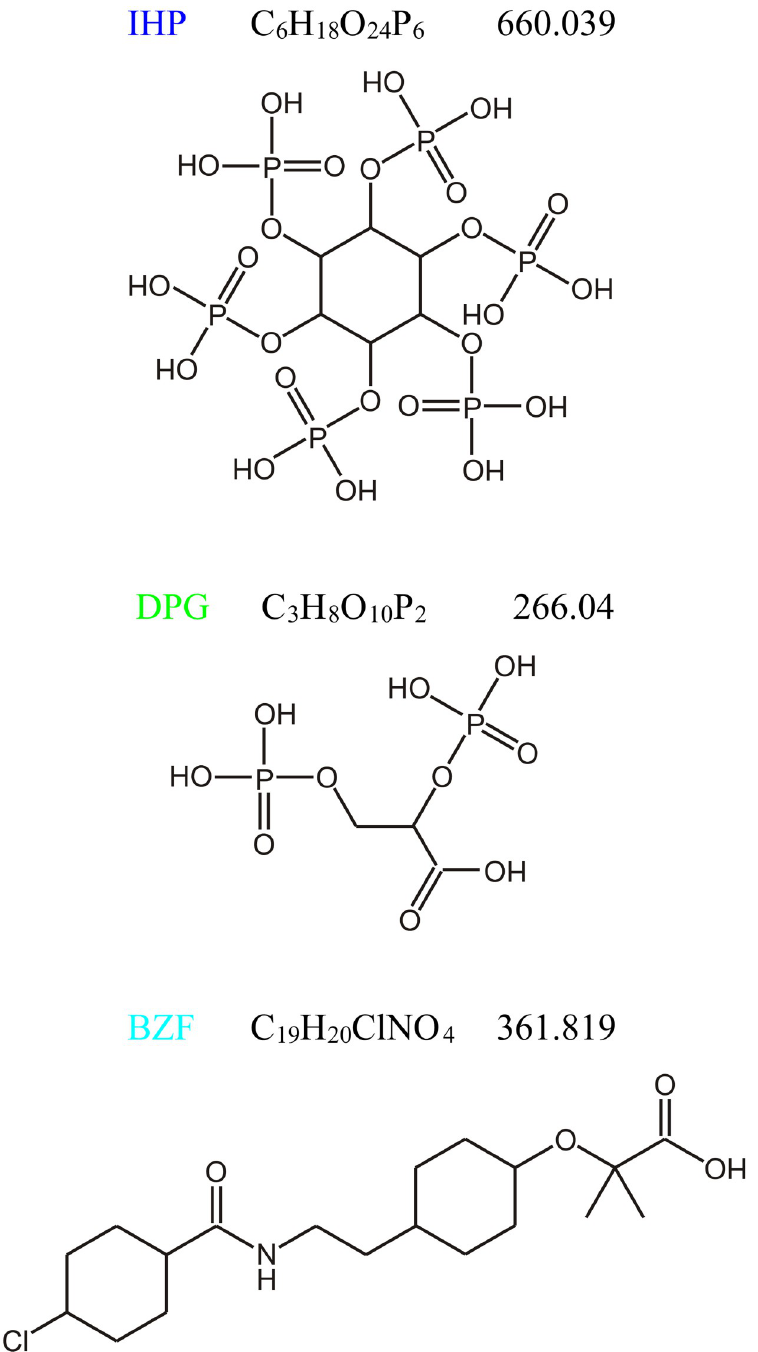
Fig 1. Chemical structure of the applied allosteric effectors (molar weights are also given): Inositol hexaphosphate (IHP), 2,3-diphosphoglycerate (DPG), bezafibrate (BZF).